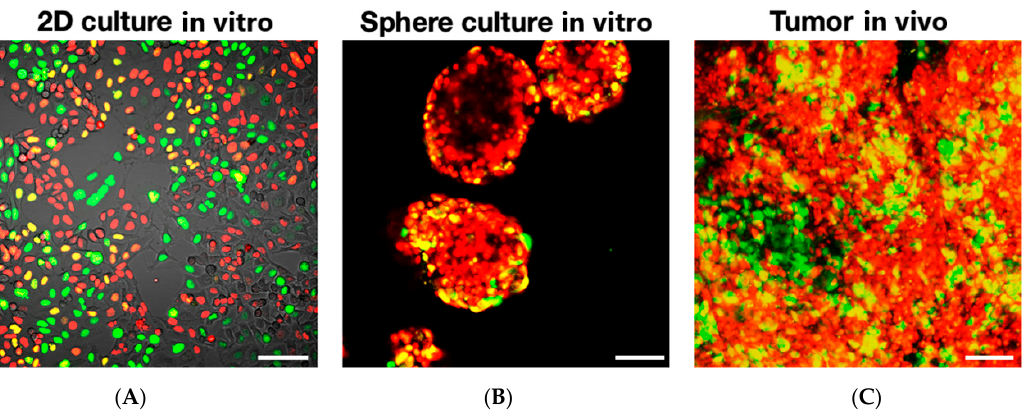
Figure 3. Representative FUCCI image of MKN45 cancer cells in 2D and 3D culture and in vivo. FUCCI cells in 2D in vitro ( A ). FUCCI cells in 3D sphere culture in vitro ( B ). FUCCI imaging of cancer cells in tumors in vivo ( C ). The cells in G 1 , early ‐ S, or late ‐ S/G 2 /M phases appear in red, yellow, or green, respectively. Note: the preponderance of FUCCI ‐ green proliferating cells in 2D ‐ culture and the preponderance of FUCCI ‐ red quiescent cells in 3D ‐ culture and in tumors. [22]. Scale bar; 100 μ m.